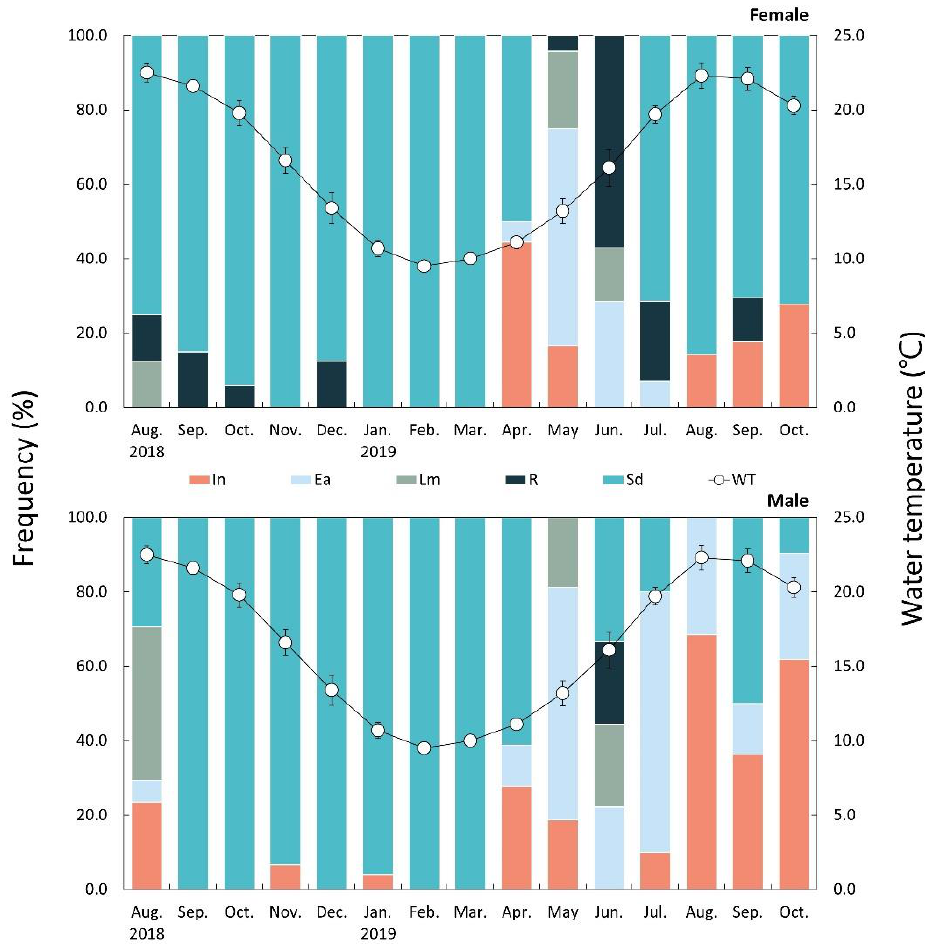
Figure 8. Monthly variations of gonadal development stage of Buccinum osagawai and water temperature in the sampling area. Ea: early active stage; In: inactive stage; Lm: late active and mature stage; R: ripe stage; Sd: spent and degenerative stage; WT: water temperature. Vertical bars indicate SD.